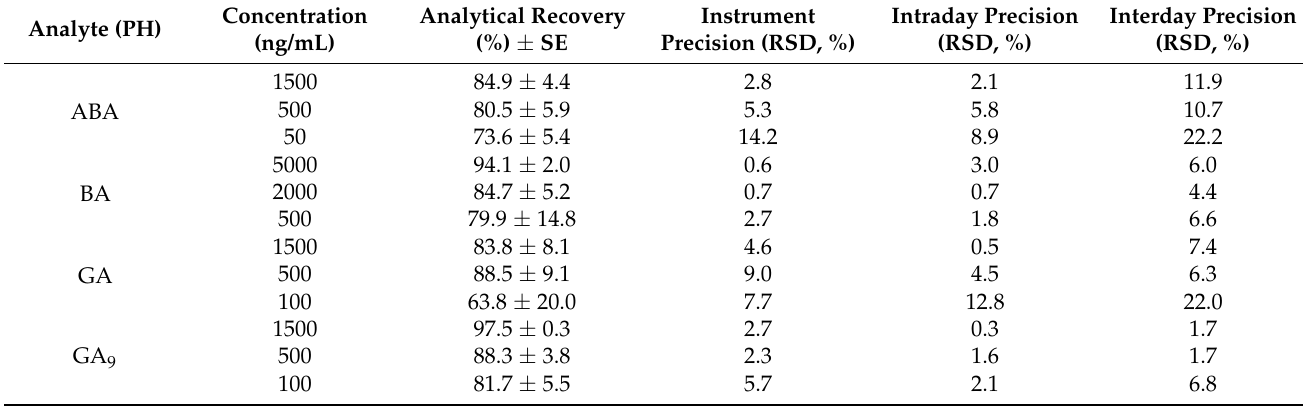
Table 3. Method validation parameters of 14 target phytohormones (PH) for three concentration levels (high, medium and low): estimated analytical recovery (%), instrument precision (relative standard deviation, RSD, %), intraday precision (RSD, %), and interday precision (RSD, %). Analytical recovery values presented as average ± standard error, n = 3 extraction rounds). RSD was determined for each phytohormone concentration level by multiplying the standard deviation by 100 and dividing this product by the